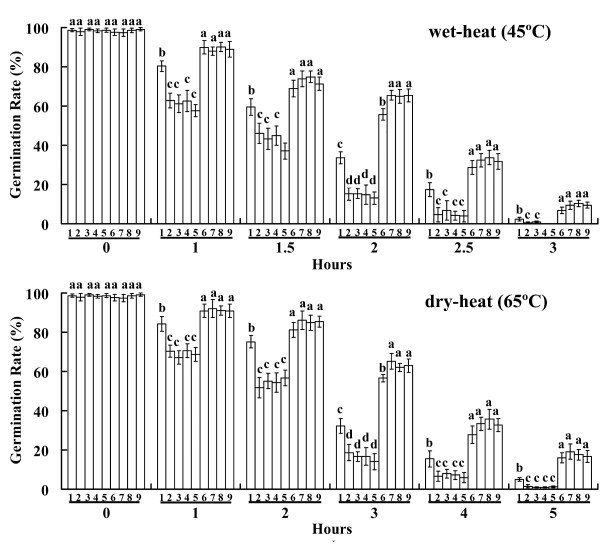
Germination rates of M. acridum wild-type strain and Ntl mutants. Wet-heat: aqueous conidial suspensions exposed to 45°C for 0, 0.5, 1, 1.5, 2, or 2.5 hours; dry-heat: dried conidia exposed to 65°C for 0, 1, 2, 3, 4, or 5 hours. 1: wild-type strain; 2-5: over-expression mutants; 6-9: RNAi mutants. Standard error bars (SE) show averages for three independent experiments. Significant differences are designated by the lowercase letters on the bars of each group (p < 0.05).